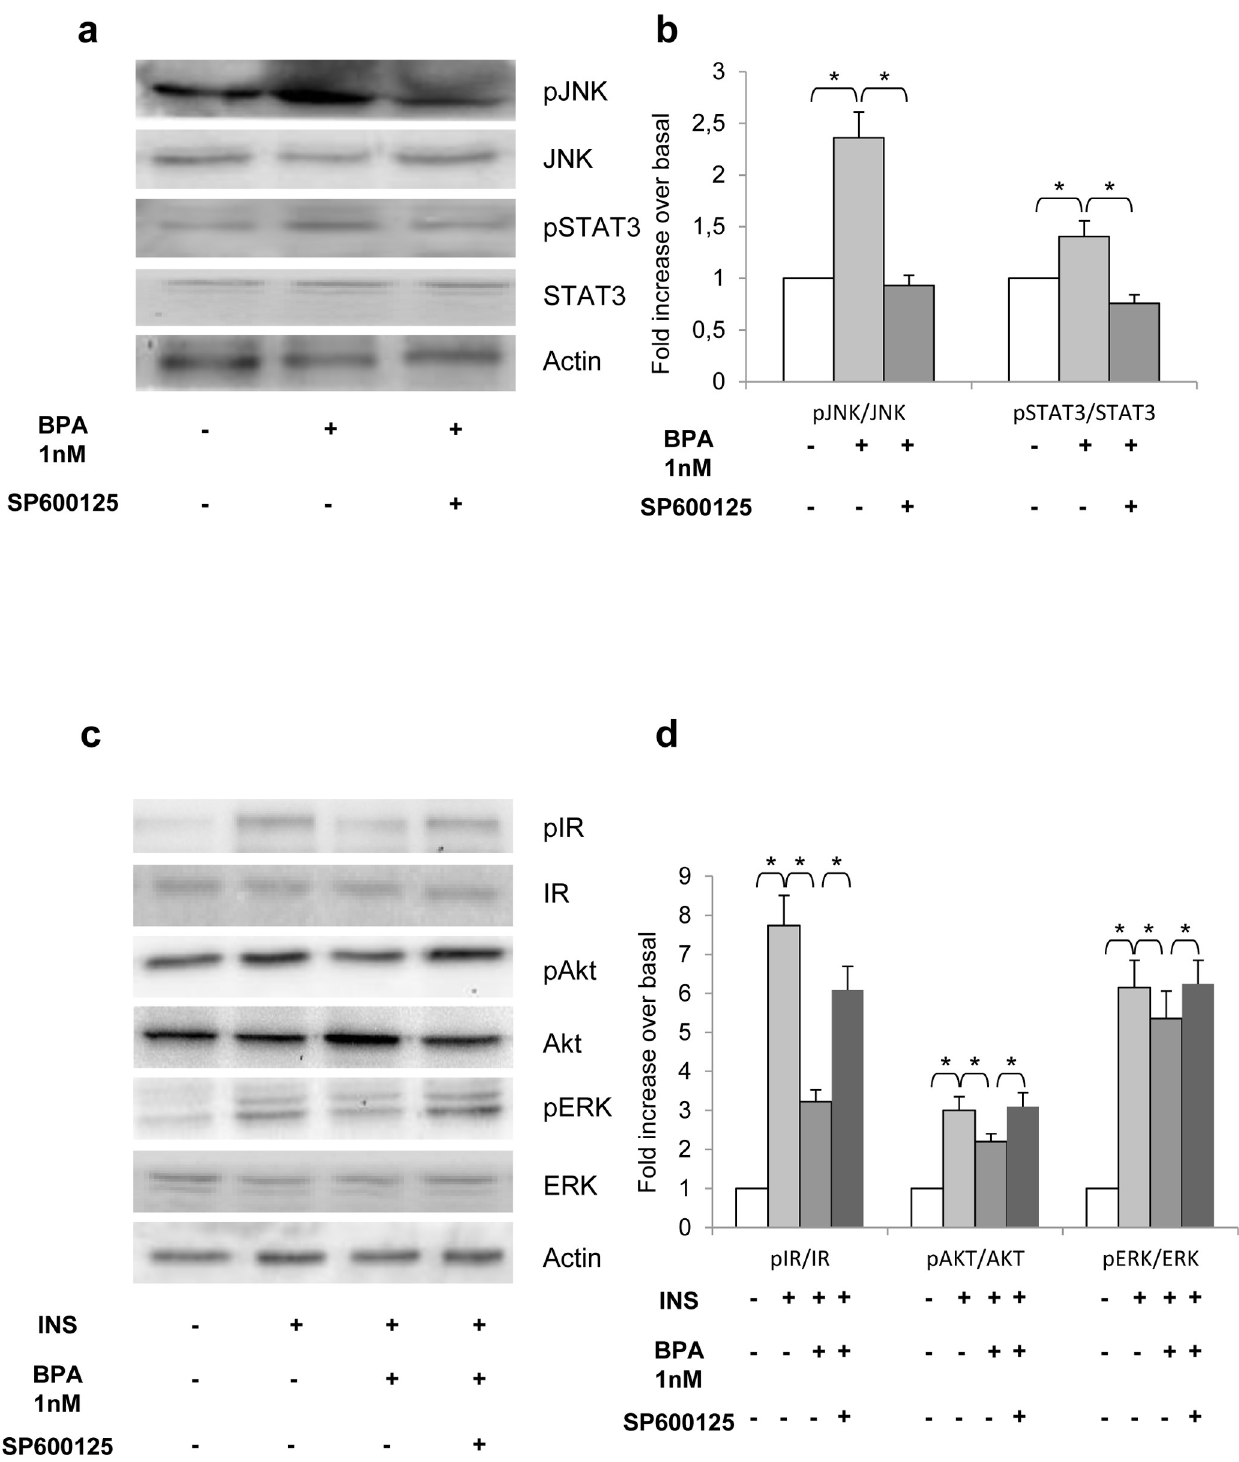
Fig 7. Effect of JAK2/STAT3 and JNK inhibition on BPA-impaired inflammatory and insulin pathways. Human adipocytes were incubated with 1 nM BPA for 24h and exposed to 20 μ M SP600125 for 1 h. a) Cell lysates (50 μ g protein/sample) were blotted with phospho-JNK and Phospho-Tyr 705 STAT3 antibodies and then reblotted with anti- JNK and STAT3 antibodies. c) Cells were treated with 100 nM insulin for 10 min and then solubilized. Cell lysates (50 μ g protein/sample) were blotted with phospho- IR, phospho- Ser 473 Akt/PKB and phospho-Thr 202 /ERK and then reblotted with anti-IR, Akt/PKB and ERK antibodies. To ensure the equal protein transfer, membranes were blotted with actin antibodies. The filters were revealed by ECL and autoradiography.